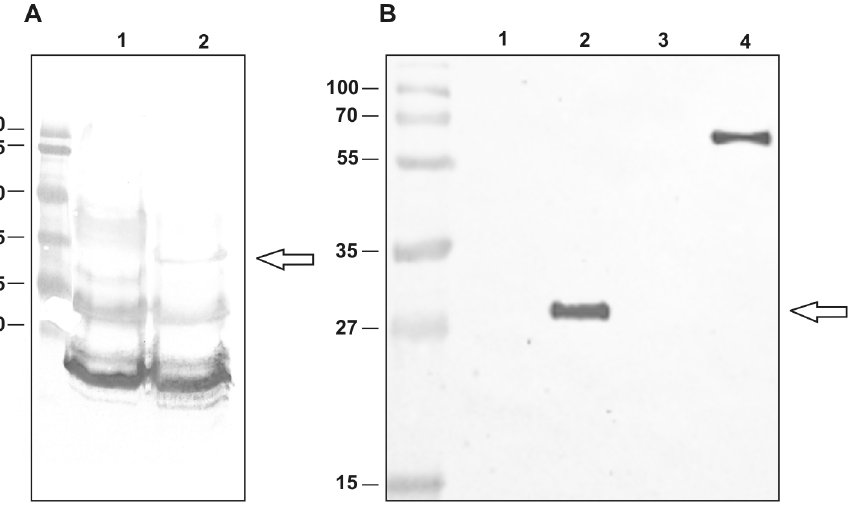
Figure 3. Western blotting analysis of expression of the cot-ureB fusion gene and the vegetative expression of the ureB gene. Panel A - Spore coat proteins were extracted analysed by western blotting with anti-CotC antibody. Spore coat proteins from spores of the 168 (lane 1) or the BKH108 (fusion CotC-UreB) (lane 2) strain. Panel B – Western blotting with anti-UreB antibody of spore coat proteins from spores of the 168 (lane 1) or BKH108 (fusion CotC-UreB) (lane 2) and of total cell protein extracts of 168 (lane 3) or BKH108 (lane 4) strain. Each lane of panel A and B was loaded with 20 m g of total proteins. Arrows points to fusion proteins.